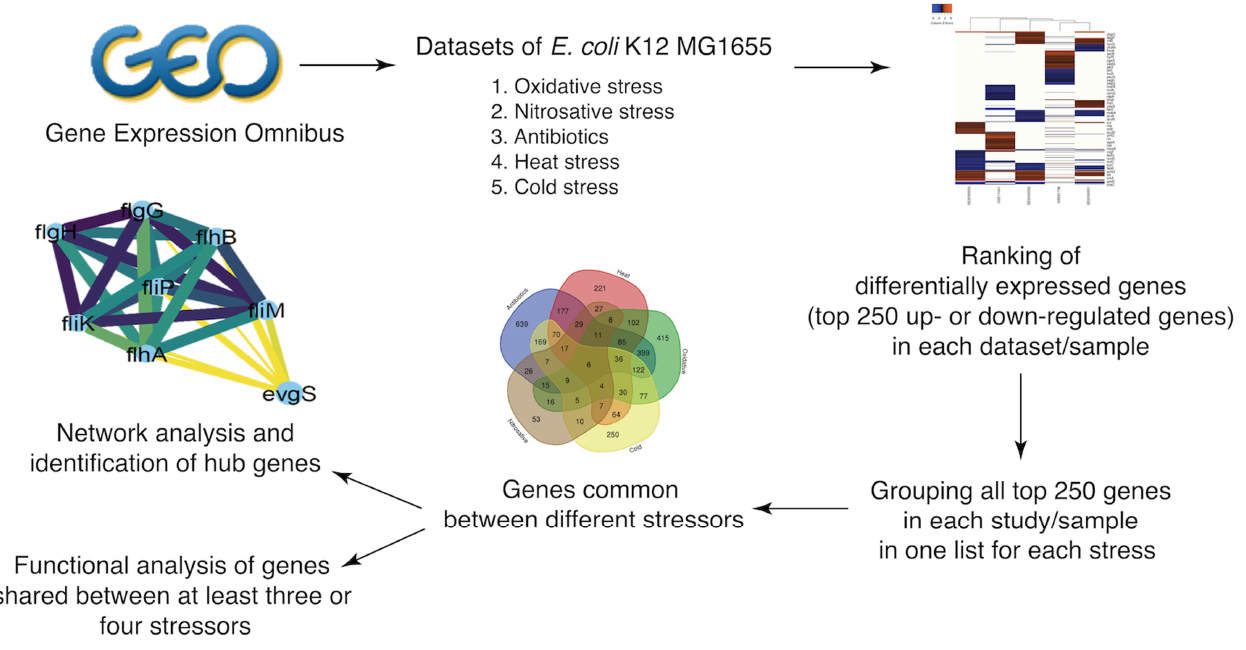
Figure 1. Workflow